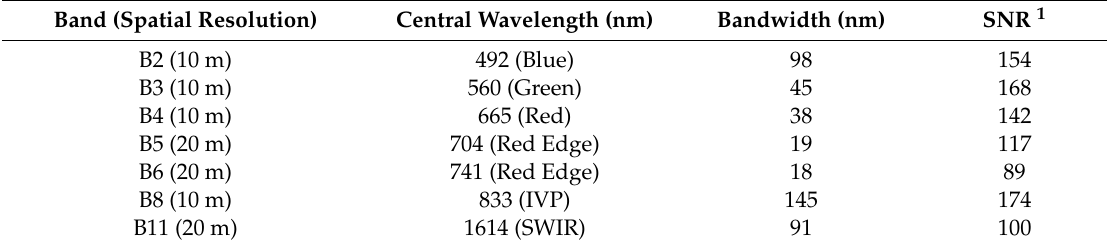
Table 2. Sentinel-2MSI spectral bands used in this